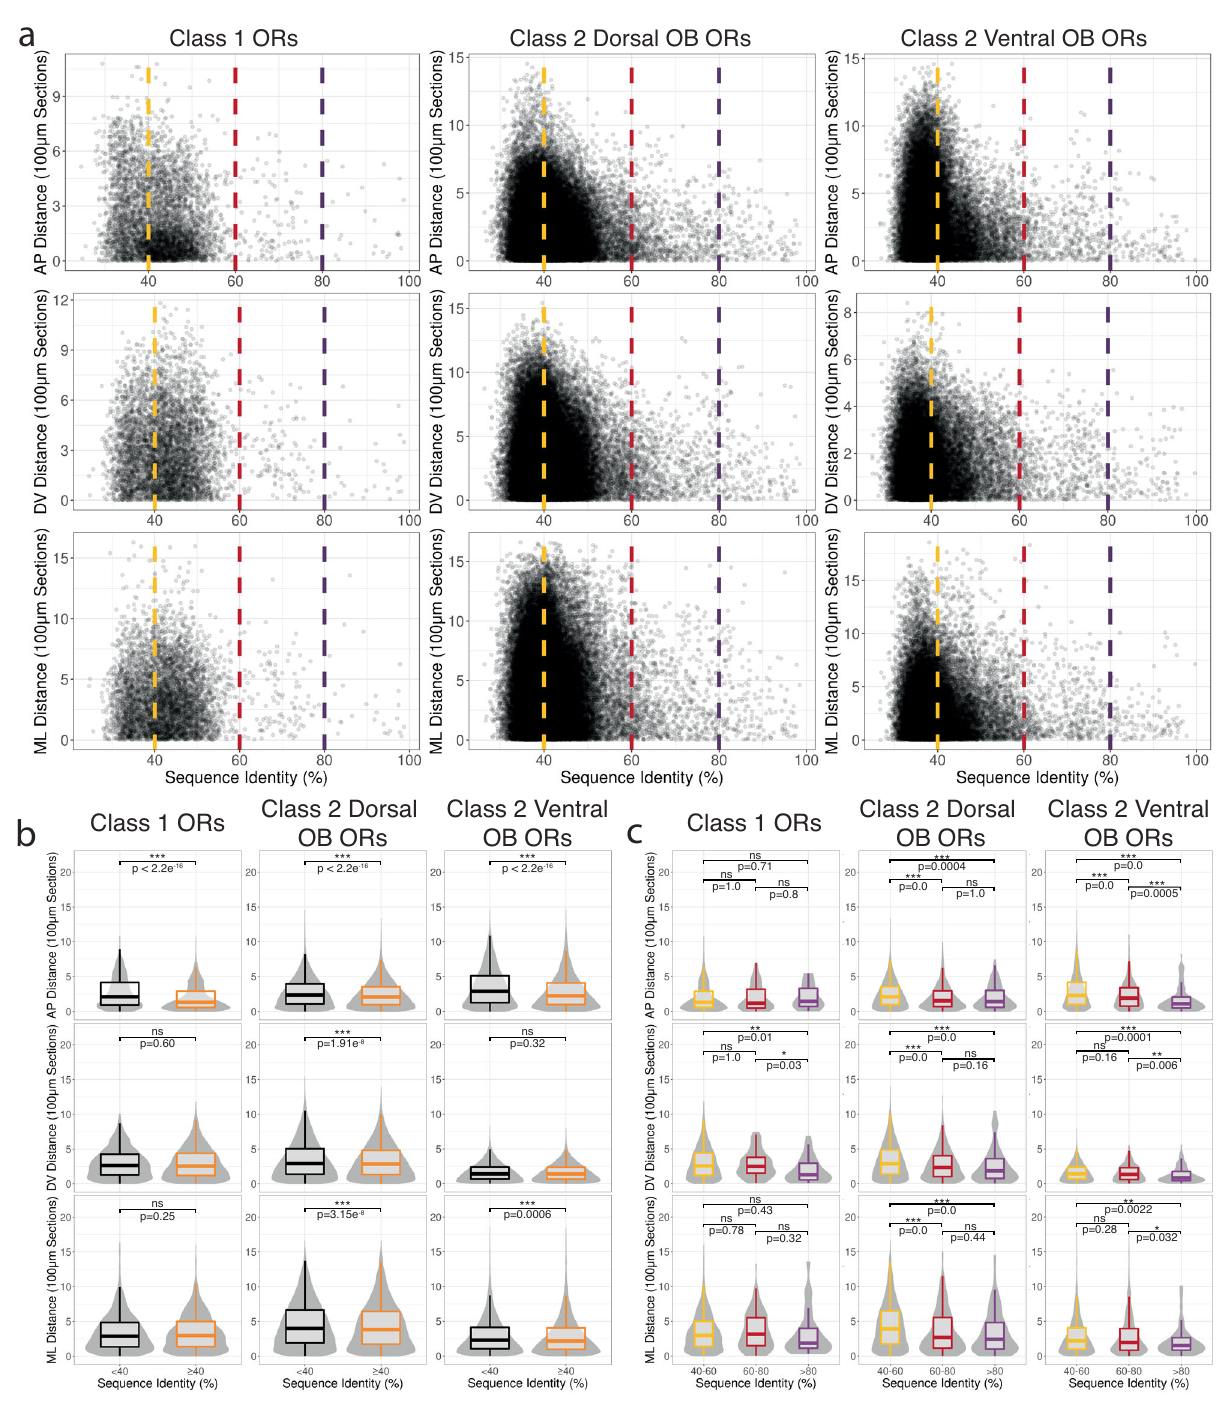
Fig. 4 | OR protein sequence similarity correlates with glomerular position more strongly among ventral than dorsal Class II ORs. a Scatter plot of mean position distance and OR protein sequence identity for ORs. Dashed lines indicate family(40% inyellow),subfamily (60%inred),and highly similar(80% in magenta) OR level homology cutoffs for the AP (top), DV (middle), and ML dimensions (bottom). Source data provided as a Source Data fi le. b Pairwise comparisons betweenmeanpositiondistanceand ORproteinsequenceidentity for ORssplitby the family level homology cutoff ( ≥ 40% in orange, <40% in black) for the AP (top), DV (middle), and ML dimensions (bottom). Class 1 ORs: n <40%=1912, n ≥ 3444;